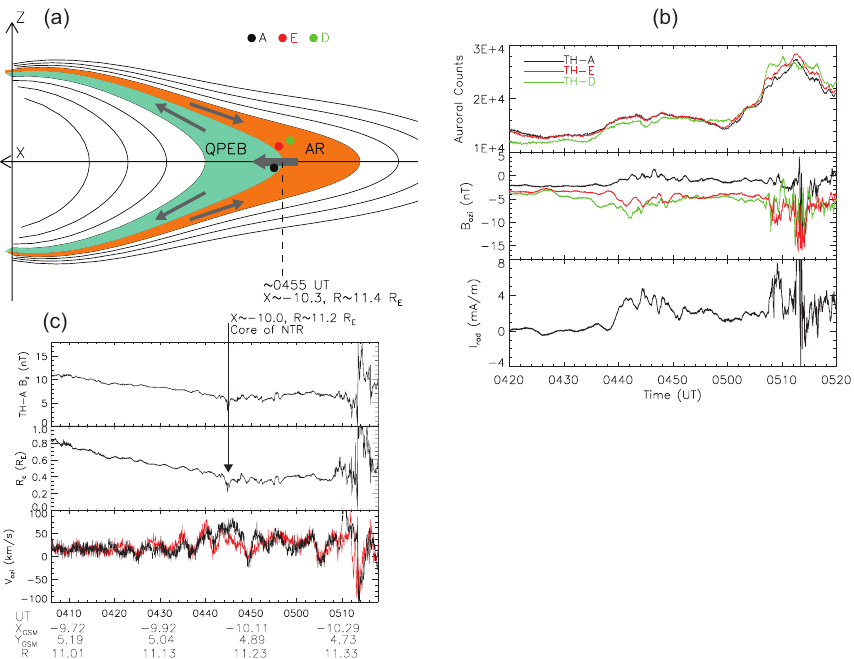
Fig. 13. (a) Schematic diagram illustrating the geometry of probes (dots with color code as labeled) with respect to QPEB and AR regions. The solid arrows mark the direction and geometry of the arc-related currents, including the FACs and their radial closure current. (b) Top panel shows the arc intensity sampled along the magnetic meridian ( ± 2 ◦ MLON) of the footprint of each probe. The second panel shows the B azi component on each probe. The bottom panel shows the estimated radial current intensity between TH-A and TH-E. (c) Top panel reproduces the B z from TH-A observations. The second panel shows the radii of curvature of magnetic field ( R c ) estimated from the measurements on TH-A and TH-E (see text for details). The “core of NTR” is estimated according to the abrupt change of the trend of B z and R c . The bottom panel shows the azimuthal ion flows on TH-A (black) and TH-E